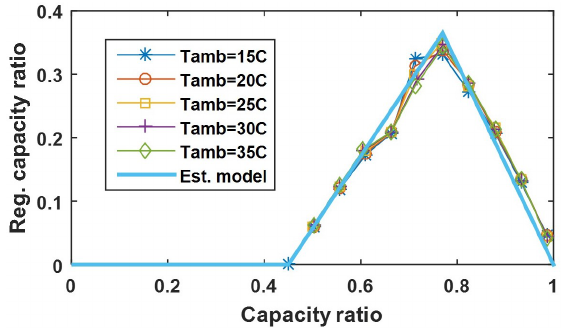
Figure 6. Variation of regulation capacity ratio with capacity